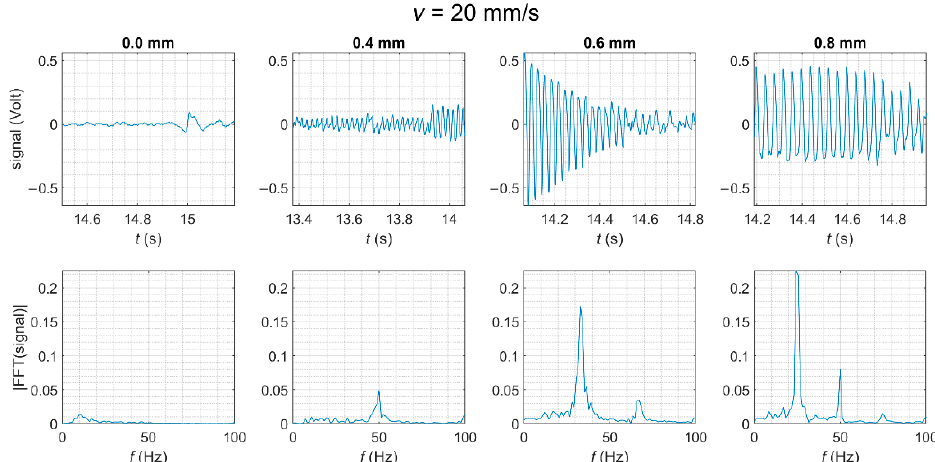
Figure 5. Temporal ( top ) and spectral ( bottom ) of the signal when the sensor is scanned over the smooth and patterned surfaces with different spatial wavelengths (0.4, 0.6, 0.8 mm) including the flat one (0 mm), at the same scanning speeds of 20 mm/s.